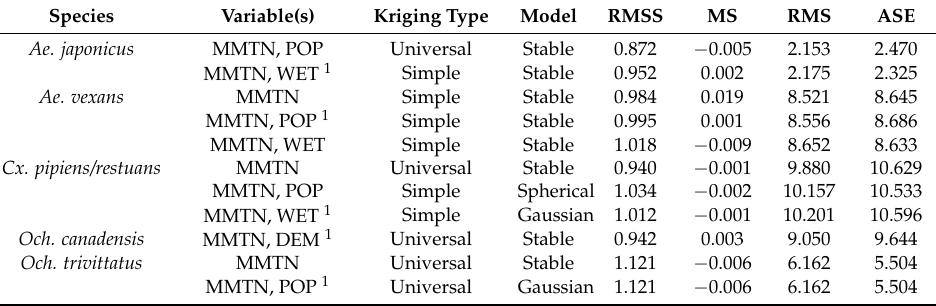
Figure 6. Standard error of prediction surfaces. ( a ) Ae. japonicus (simple kriging: MMTN, WET); ( b ) Ae. vexans (simple kriging: MMTN, POP); ( c ) Cx. pipiens / restuans (simple kriging: MMTN, WET); ( d ) Och. canadensis (universal kriging: MMTN, DEM); ( e ) Och. trivittatus (universal kriging: MMTN, POP). Abbreviations: DEM, digital elevation model; MMTN, mean number of mosquitos per trap-night; POP; proximity to population centres; WET, proximity to wetlands. Table 2. Prediction error summary of kriged data sets. Abbreviations: MMTN, mean number of mosquitoes per trap-night; DEM, digital elevation model; POP; proximity to population centres; WET, proximity to wetlands; RMSS, root mean square standardized; MS, mean standardized; RMS, root mean square; ASE, average standard